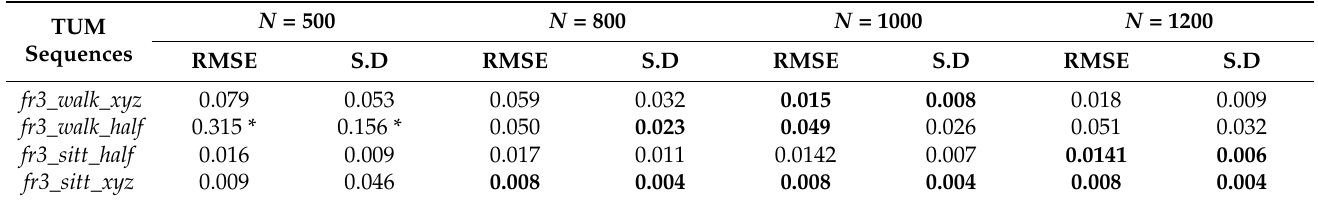
Table 1. The ATE-RMSE (m) of the RGB-D camera using different particle numbers.